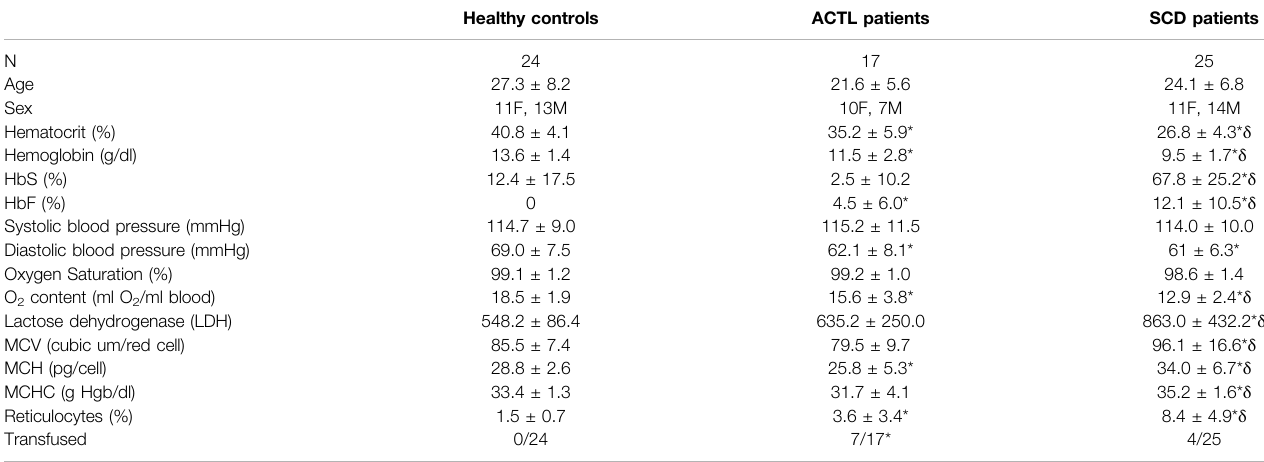
TABLE 1 | Subject demographics. Group averages and standard deviations are given. Healthy controls ACTL patients